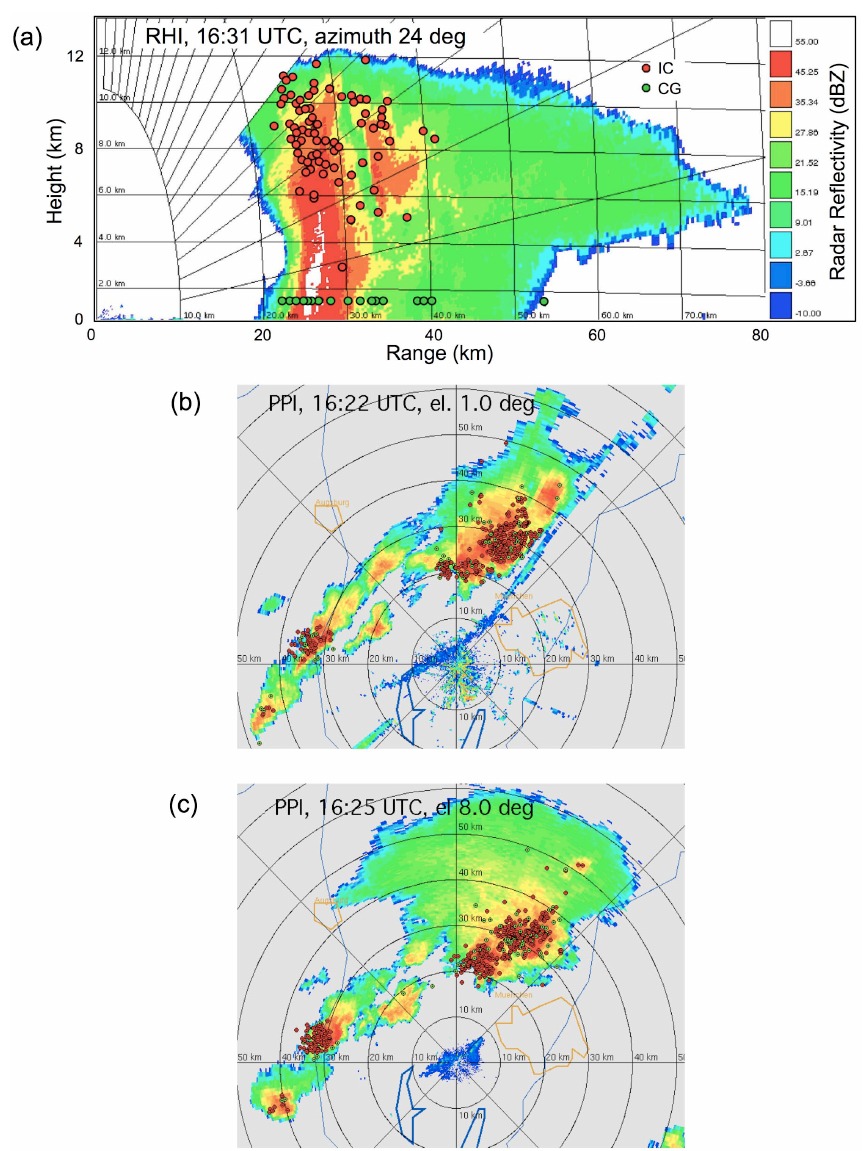
Fig. 4. Reflectivity scans of the example storm recorded by POLDIRAD on 25 June 2008. Electrical discharge events recorded by LINET from 2min prior to 2min after the radar mapping times are illustrated. Red indicates IC events, green CG events. (a) RHI scan. To better visualize distant CG events, the LINET ground strike points are plotted at 1.5km height. (b) PPI scan recorded with an elevation angle of 1 ◦ . (c) PPI scan recorded with an elevation angle of 8 ◦